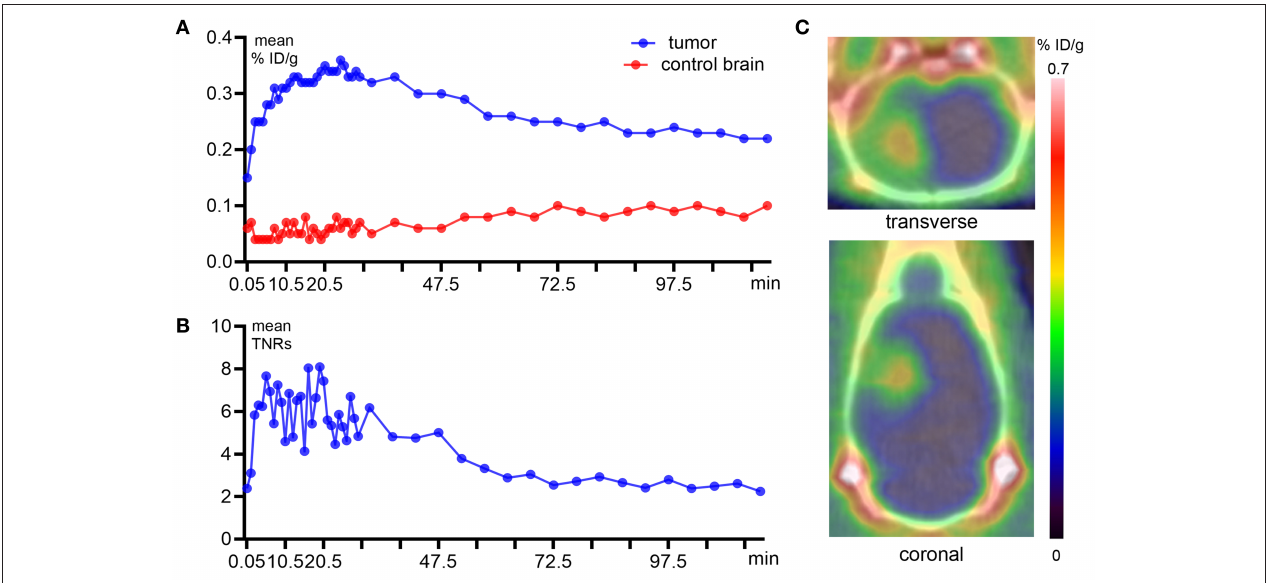
FIGURE 2 | Dynamic PET imaging with S- [ 18 F]CF 3 -D-CYS and quantitative analysis derived from a C6 orthotopic tumor model. (A) Quantitative analysis of the tumor and control brain uptake during 2h after S- [ 18 F]CF 3 -D-CYS administration. (B) The time–activity curves of uptake ratios of the tumor to normal brain.